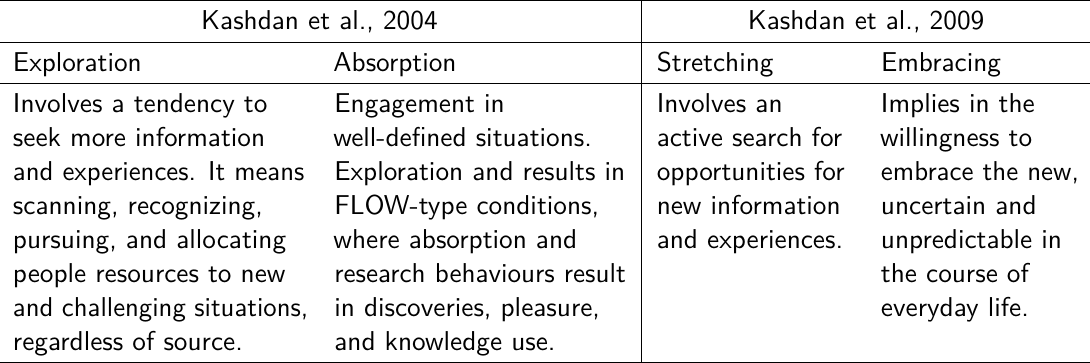
Table 1. CEI- I and CEI- II - Main